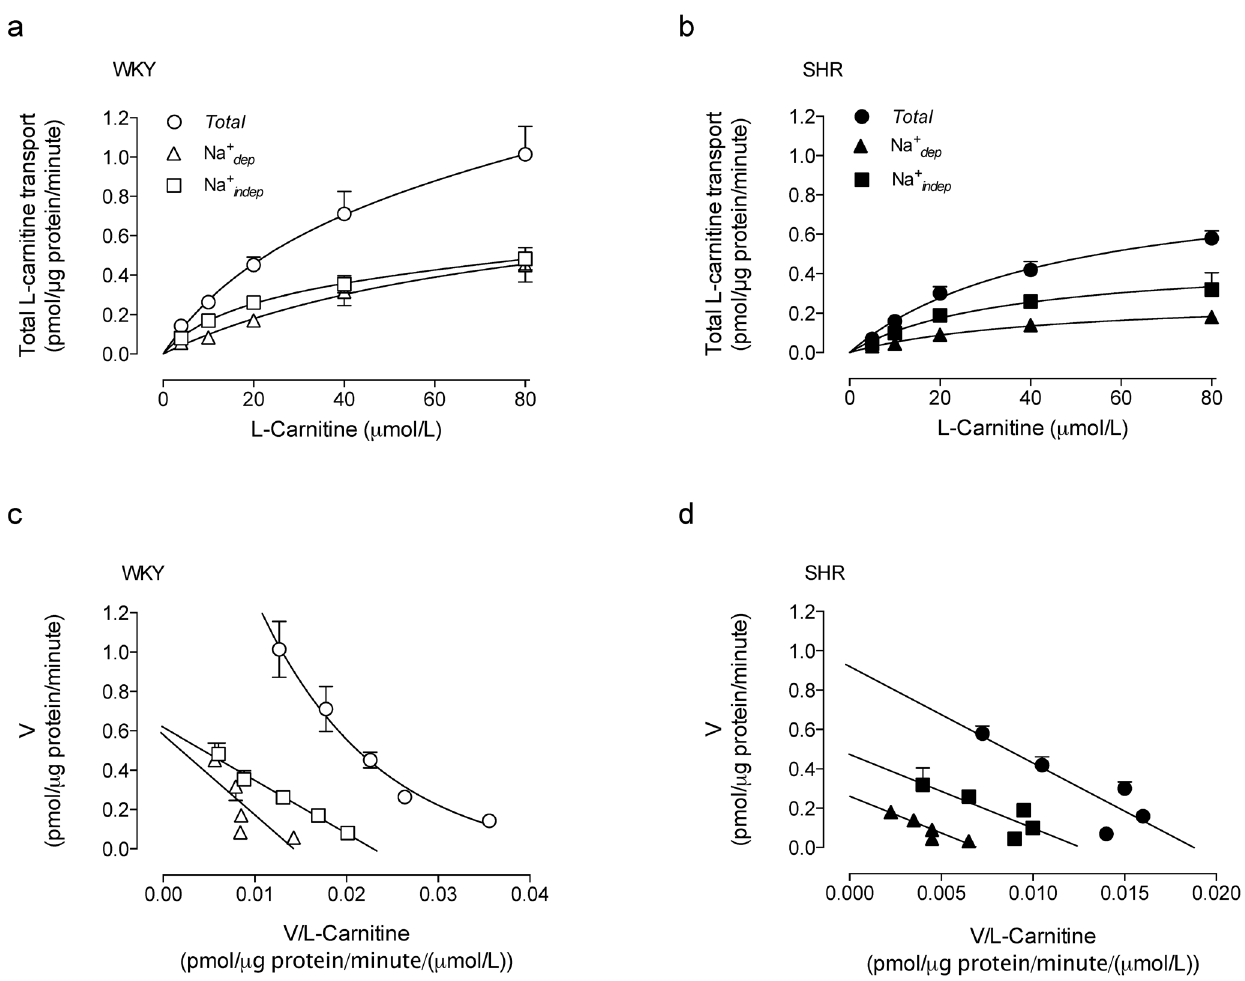
Figure 3. Total transport of L-carnitine kinetics. Total transport of L-carnitine ( Total ), and the Na + -dependent (Na + dep ) and Na + -independent (Na + indep ) transport components (0–80 m mol/L L-carnitine, 3 m Ci/mL L-[ 3 H]carnitine, 30 seconds, 37 u C) in RAECs cultures from WKY rats (a) or SHR (b). The Eadie-Hofstee plots for transport data in shown for WKY rats (c) and SHR (d) from data in (a) and (b), respectively. Values are mean 6 SEM